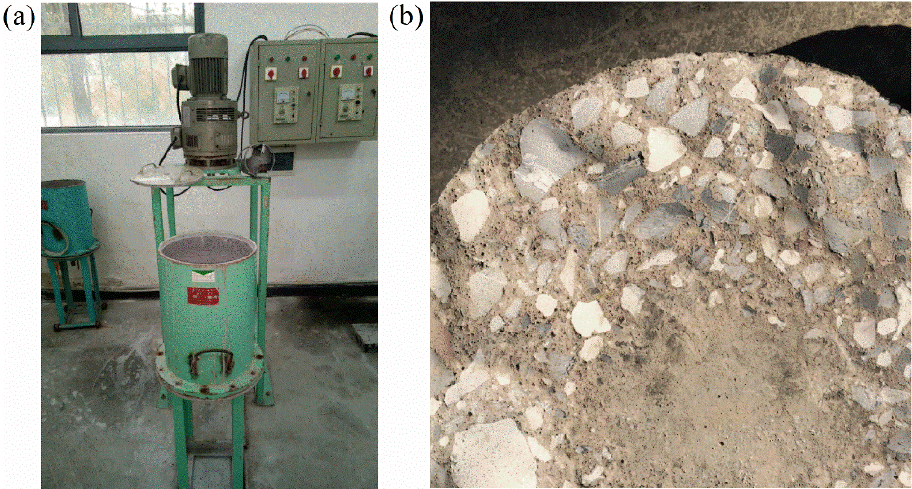
Figure 2. Abrasion resistance test: ( a ) the underwater method instrument and ( b ) the abrasively damaged concrete specimen.